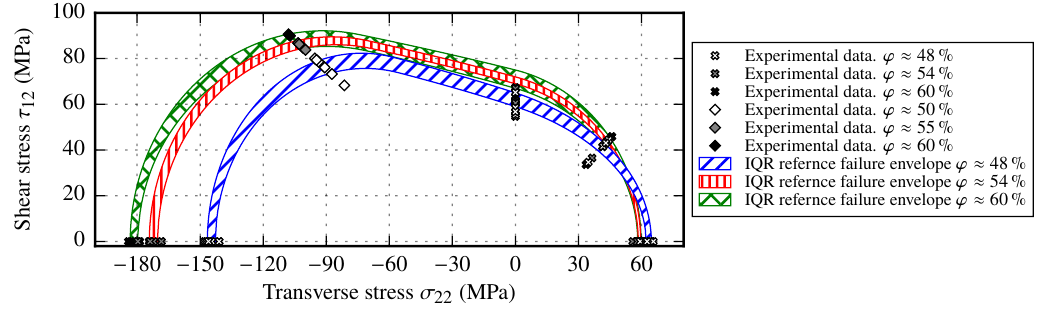
Figure 21. Resulting failure envelope ranges for reference samples at three different fiber volume